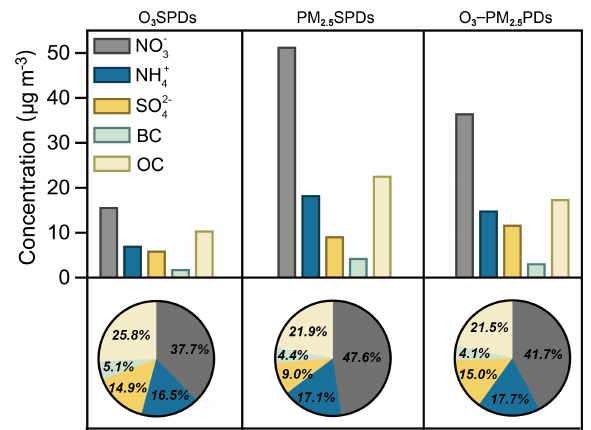
Figure 6. The concentrations of PM 2 . 5 components (µgm − 3 ) and percentages of PM 2 . 5 components (%) at the surface for NO − NH + , SO 2 − , BC, and OC. The values were averaged over the 4 4 model-captured O 3 SPDs, PM 2 . 5 SPDs, and O 3 –PM 2 . 5 PDs in the months of April to October of 2013–2020 in